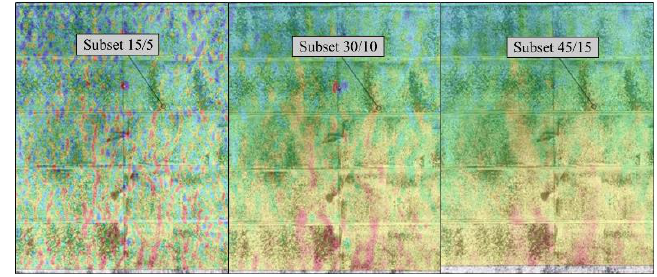
Figure 10. Crack detection for different subset sizes—lab test.